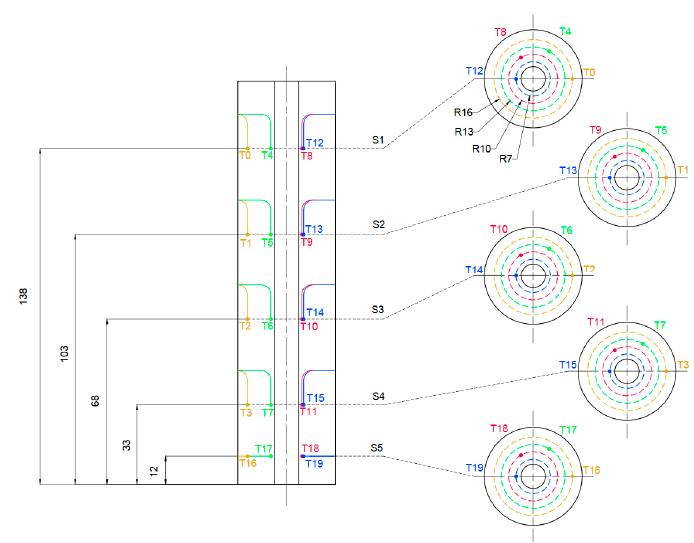
Figure 5. Arrangement of temperature sensors inside the experimental module with a straight working element: S1 to S5 surfaces in subsequent cross-sections. Energies 2020 , 13 , x FOR PEER REVIEW